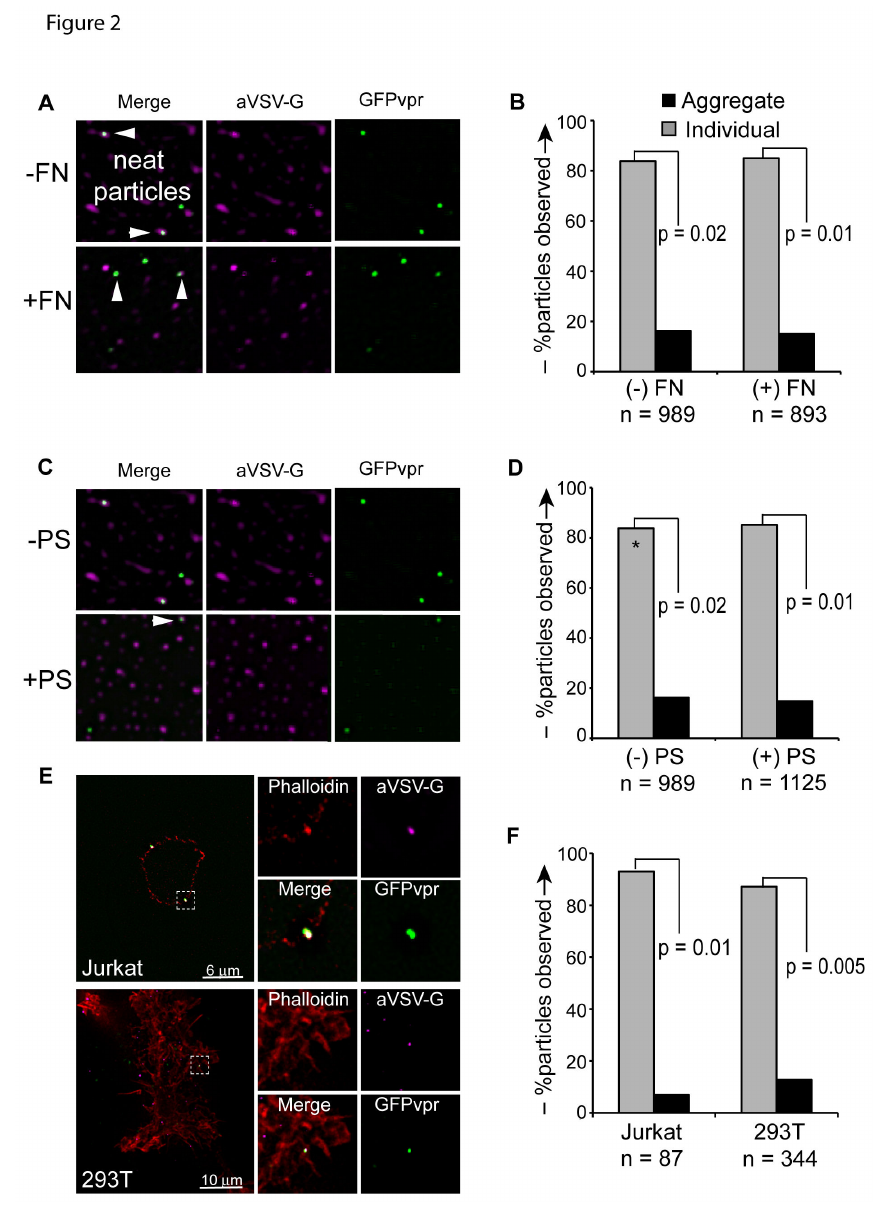
Figure 2. VSV-G pseudotyped lentivector particles do not form aggregates. ( A ) GFP vpr labeled vector particles were allowed to settle on glass slides in the absence (top) or presence (bottom) of recombinant fibronectin fragment, CH296, stained with anti- VSV-G antibody and Alexa Fluor 647 anti-mouse secondary antibody, and visualized via deconvolution microscopy. ( B ) Particles either counted as “individual” (gray bars) or as “aggregate” (black bars) if 2 or more individual particles were observed to occupy contiguous space. Significance was determined by performing a Student’s 2-tailed t-test , assuming unequal variance between groups. ( C ) GFP vpr labeled particles were allowed to settle on glass slides in the absence (top) or presence (bottom) of 8 µg/ml protamine sulfate. ( D ) Particles either counted as “individual” (gray bars) or as “aggregate” (black bars) if 2 or more individual particles were observed to occupy contiguous space. Asterisk indicates that data set for “(-PS) control is the same from (B), “(-FN)” control. Significance was determined by performing a Student’s 2-tailed t-test , assuming unequal variance between groups. ( E ) Jurkat (top panels) and 293T cells (bottom panels) were exposed to GFP vpr vector particles (green) for 1 hour at 37C, washed, and fixed with 4% paraformaldehyde. Cells were stained with phalloidin (red) and anti-VSV-G antibody (magenta), followed by staining with anti-rabbit Alexa Fluor 647 (blue), and imaging via deconvolution microscopy. ( F ) Particles either counted as “individual” (gray bars) or as “aggregate” (black bars) if 2 or more individual particles were observed to occupy contiguous space. Significance was determined by performing a Student’s 2-tailed t-test , assuming unequal variance between groups. doi: 10.1371/journal.pone.0074925.g002 PLOS ONE |